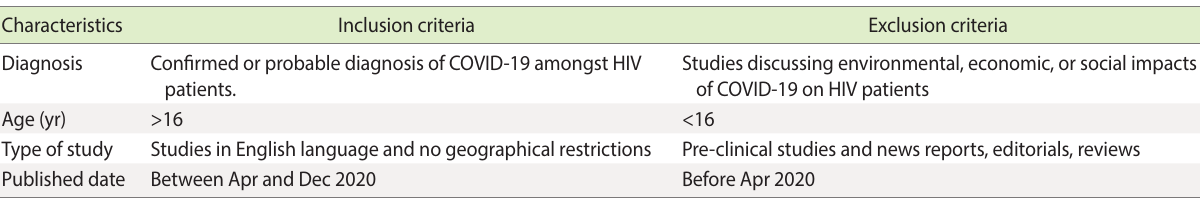
Table 1. Inclusion and exclusion criteria for the search